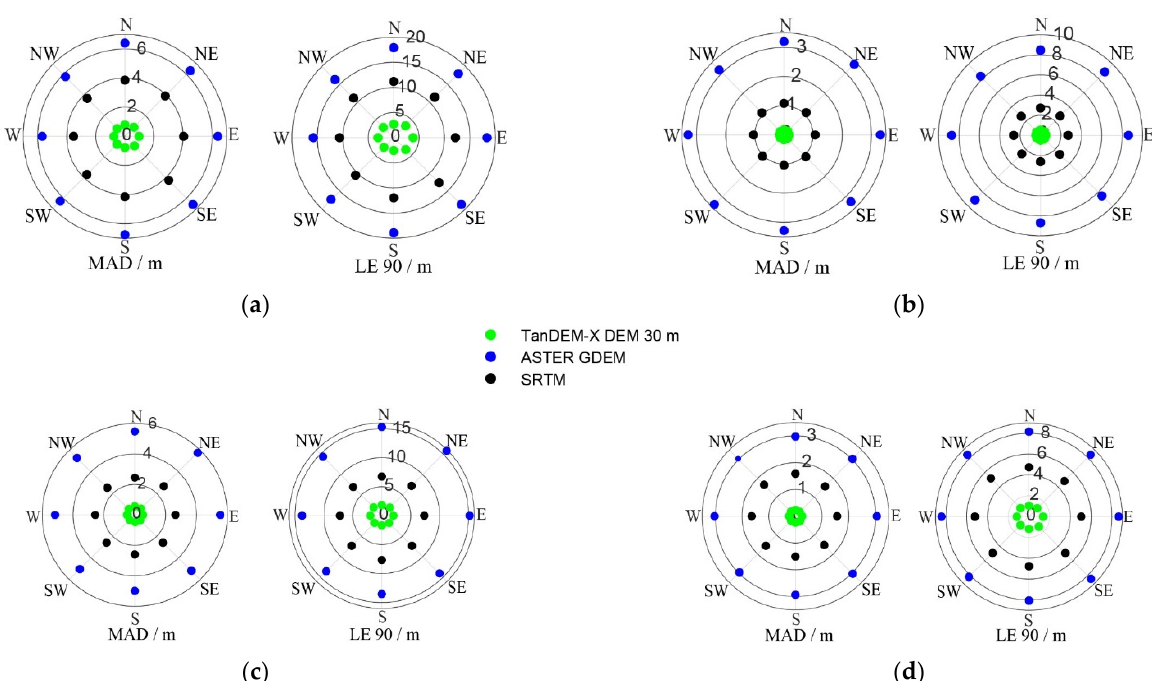
Figure 15. The relationship between quality indicators ((left) MAD and (right) LE90) and aspects in four study areas: ( a ) Sichuan; ( b ) Xinjiang A; ( c ) Xinjiang B; and ( d ) Inner Mongolia.